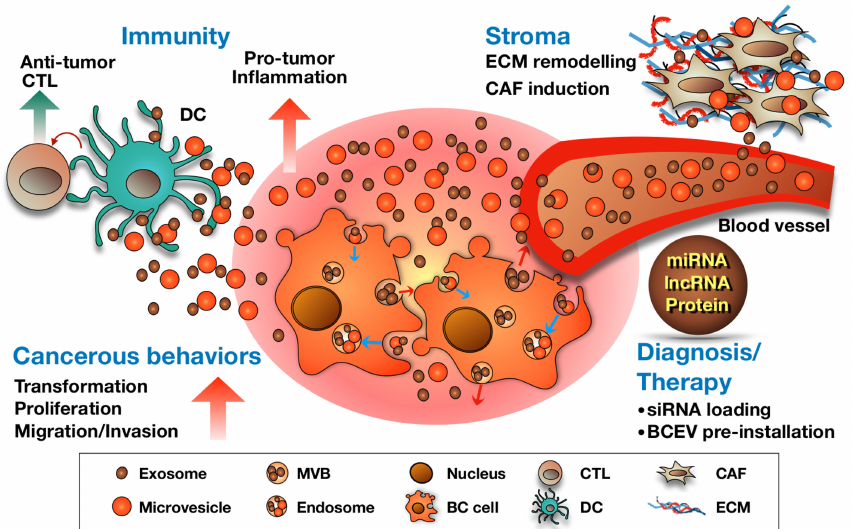
Figure 2. Summary of the roles of BCEVs in cancer, the tumor microenvironment and therapeutic applications. BCEVs are involved in many aspects of cancer development and progression. Like other cancer cells, BC cells release EVs into extracellular spaces and can be received by urothelial cells and immune cells, consequently modifying their behavior to support or suppress tumor growth (red and blue arrows indicate the migrating direction of intracellular vesicles). On the one hand, BCEVs can promote neighboring recipient cells’ cancerous behaviors, including malignant transformation, proliferation, migration and invasion, as well as modify the tumor microenvironment in favor of tumor outgrowth, including promoting inflammation, ECM remodeling and fibroblast differentiation to cancer-associated fibroblasts (CAF). In contrast, BCEVs also participate in the immune surveillance system by presenting tumor antigens to provoke dendritic and cytotoxic T cell anti-tumor immunity. With specific cargoes carried by BCEVs such as miRNA, lncRNA and proteins, their clinical application, particularly in disease biomarkers, has rapidly expanded. Moreover, researching the utilization of BCEVs as vesicles to deliver therapeutic materials is also